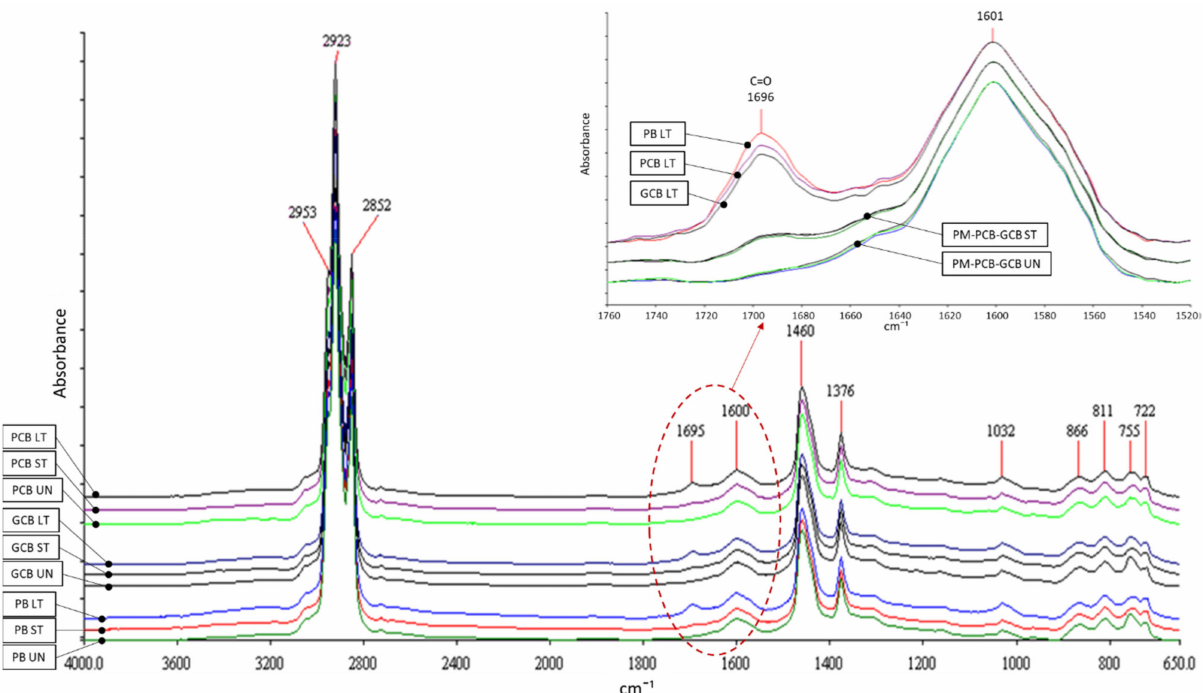
Figure 9. Average FTIR spectra of bituminous blends under different aging conditions. Inset shows the magnification of the FTIR spectra in the spectral range 1760–1500 cm − 1 .